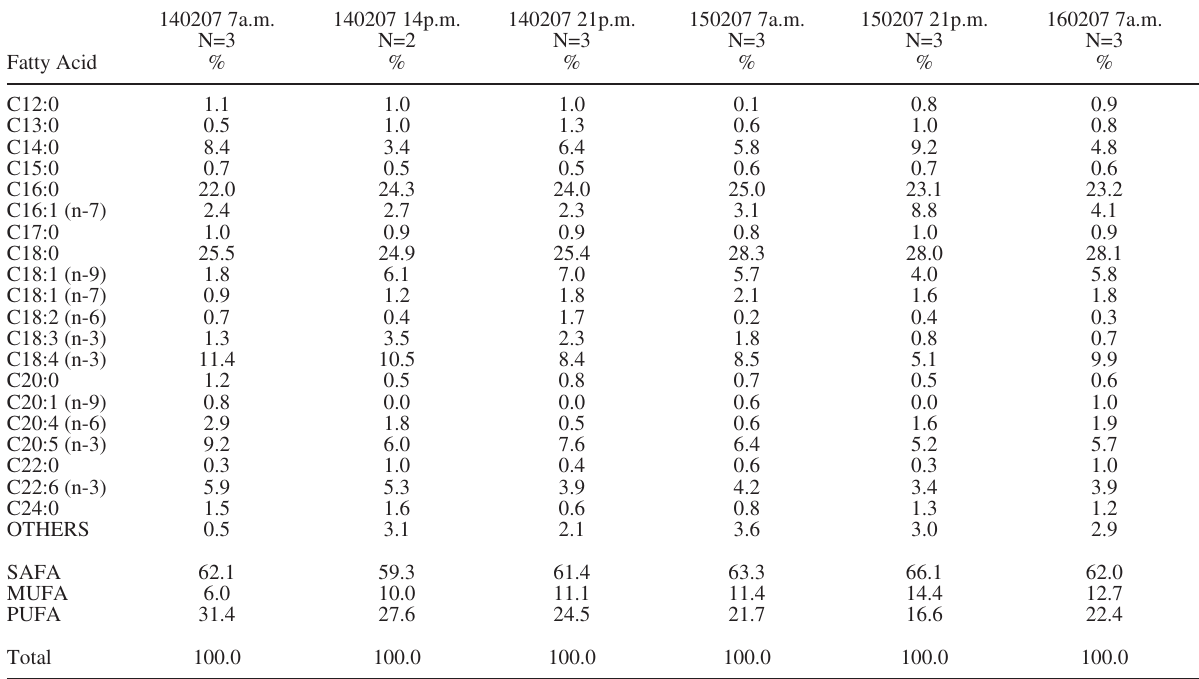
Table 3. – Fatty acid composition (% of the total fatty acids) in the near shore intensive cycle at Chipana Bay (from 14 to 16 February 2007). 140207 7a.m.